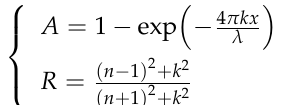
where ε 1 is the real part and ε 2 is the imaginary part of the complex